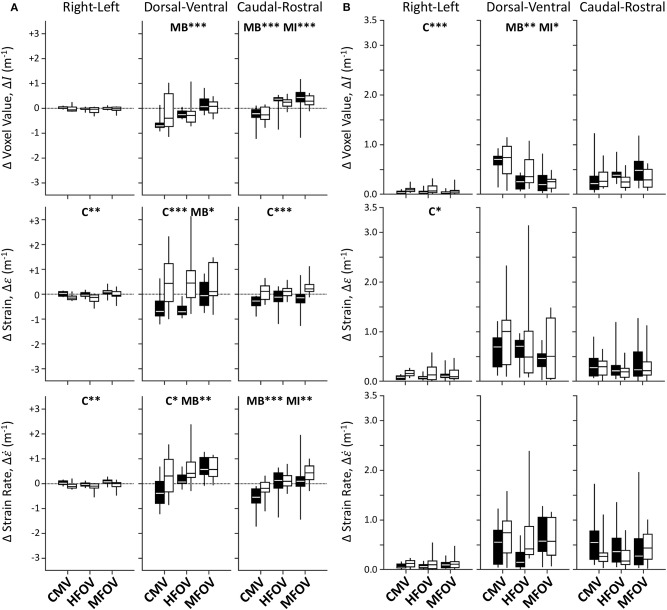
Mean-normalized spatial gradient values (A) and magnitudes (B) for image registration-based regional ventilation measures of intratidal changes in aeration (ΔI), volumetric strain (Δε), and volumetric strain rate (Δε˙). Linear spatial gradients in each of the three principal anatomic directions throughout the lung mask are shown for each variable, represented by box plots showing minimum, maximum, and quartiles across subjects under baseline (black) and injured (white) conditions, during conventional mechanical ventilation (CMV), high-frequency oscillatory ventilation (HFOV), and multi-frequency oscillatory ventilation (MFOV). Asterisks indicate significance levels (*p < 0.05, **p < 0.01, ***p < 0.001) for main effects (C = lung condition, MB = modality for baseline condition, MI = modality for injured condition). See Table 2 for additional clarification.